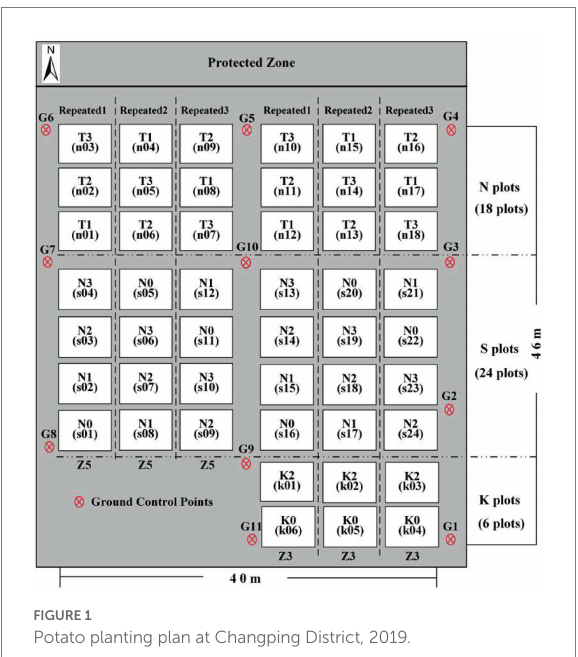
FIGURE 1 Potato planting plan at Changping District,